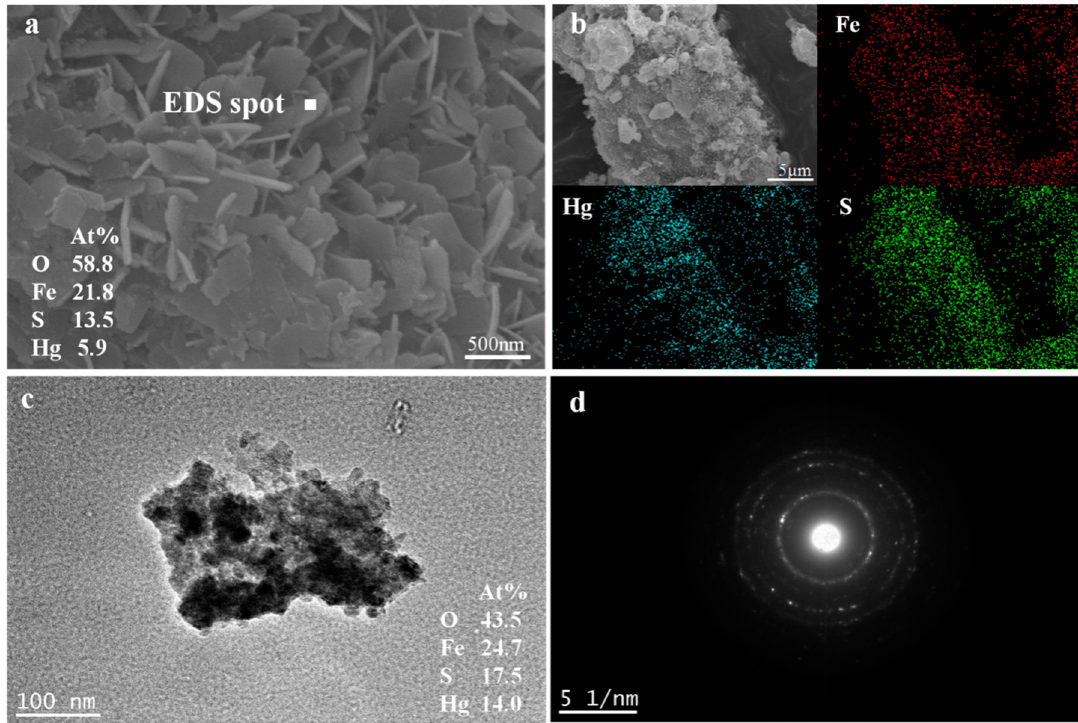
Figure 10. ( a ) SEM-EDS characterization. ( b ) SEM image with EDX mapping for different elements (Fe, S, and Hg). ( c ) TEM image, and ( d ) electron diffraction spot pattern of the used MPy-600.